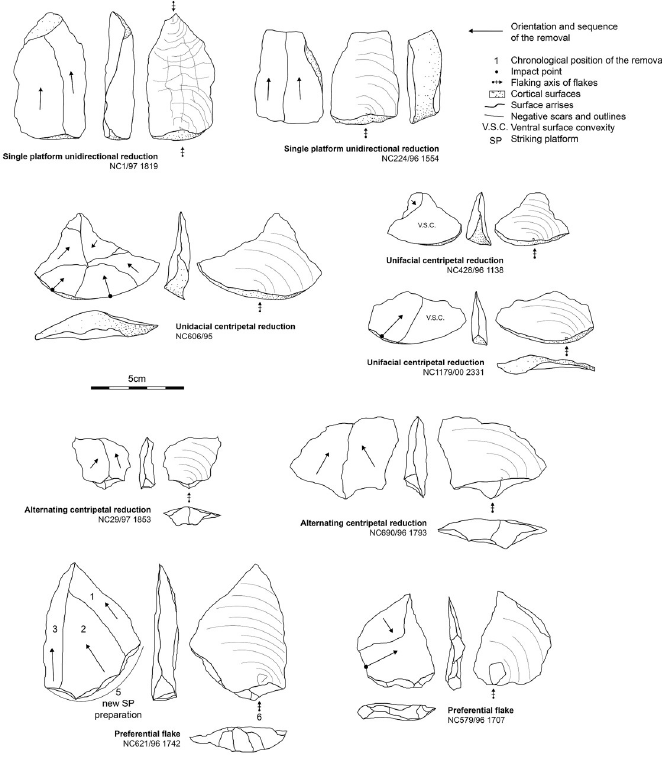
Fig 8. Quartz flakes from Dungo IV and their association with specific core reduction